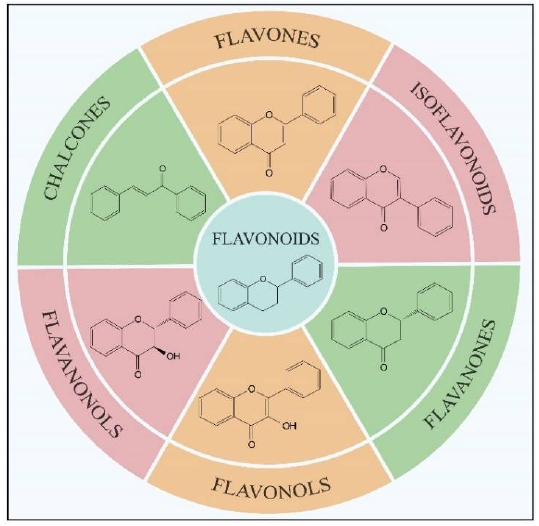
Figure 1. Main subclasses of flavonoids according to their structural formulas.